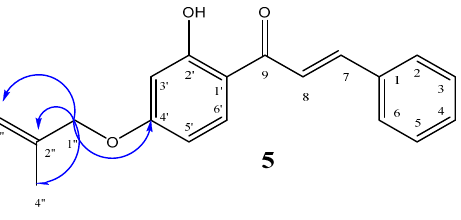
Figure 2. Most important correlations 2D 1 H– 13 C HMBC, compound 5 .